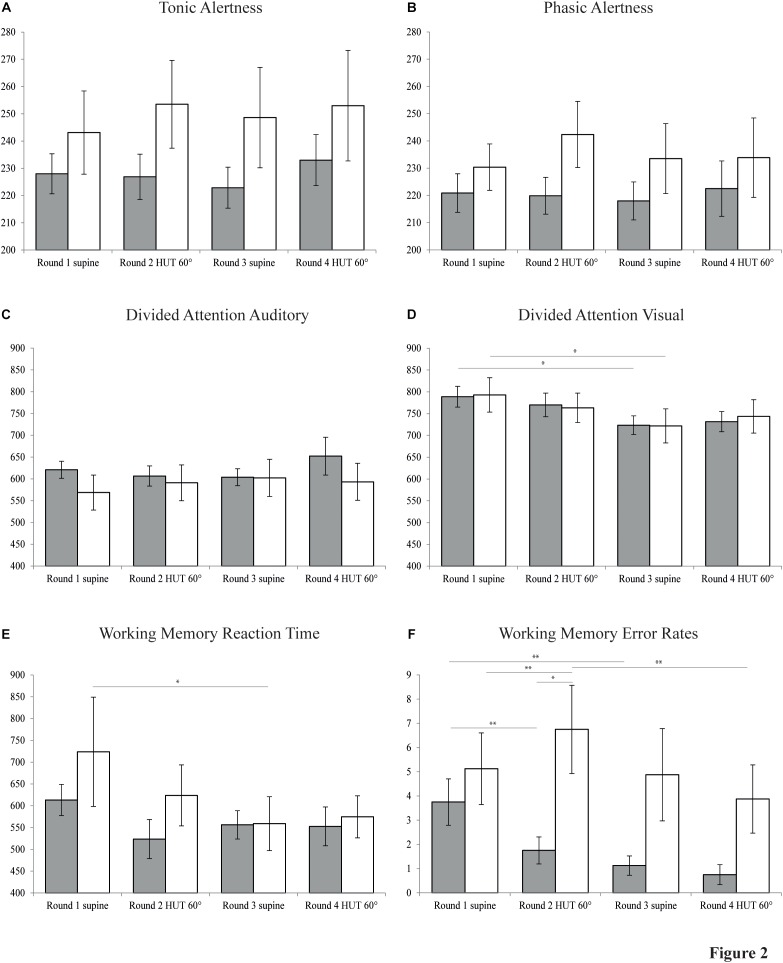
Neuropsychological data. Bar graphs showing results of four rounds of neuropsychological testing in patients with POTS (white bars) and control subjects (gray bars) in the supine and 60° head-up tilt (HUT) position, each before and after the intake of water. (A) Tonic alertness. (B) Phasic alertness. (C) Divided attention auditory. (D) Divided attention visual. (E) Working memory reaction time. (F) Working memory error rates. Y-axes of plots A to E indicate reaction time (ms). Y-axis of plot F indicates cumulative number of errors and omissions. Values are given as means ± S.E.M. ∗P ≤ 0.05; ∗∗P ≤ 0.01.